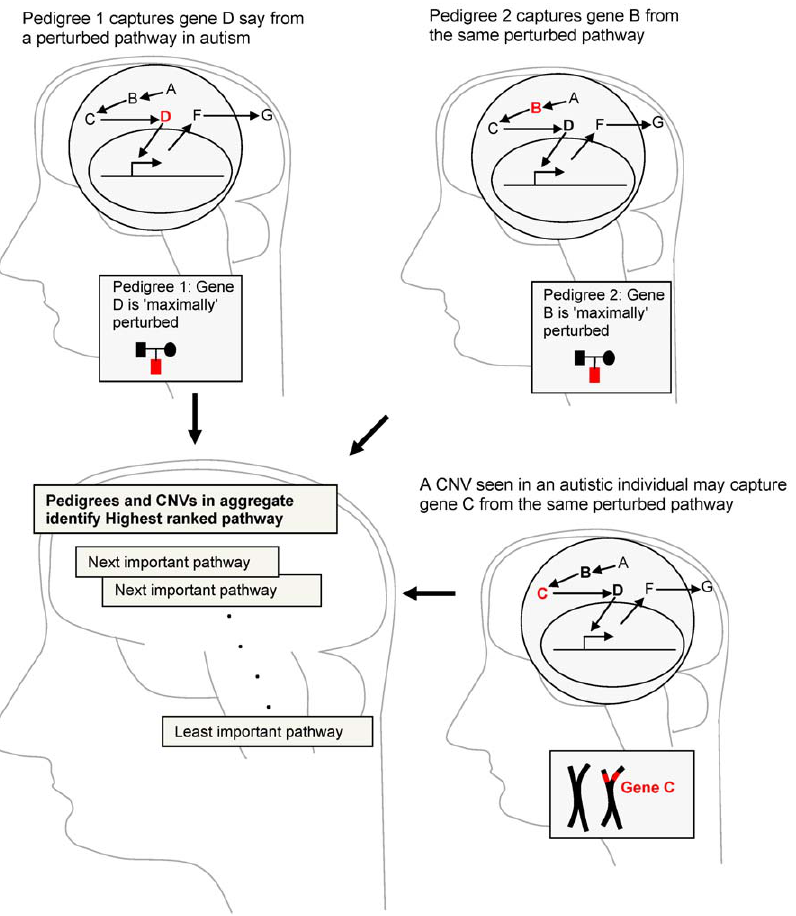
Figure 1. A conceptual picture of our overall analysis. Each affected individual from different pedigrees captures a different part of the same pathway. The same will be true of different CNVs in different autistic individuals.